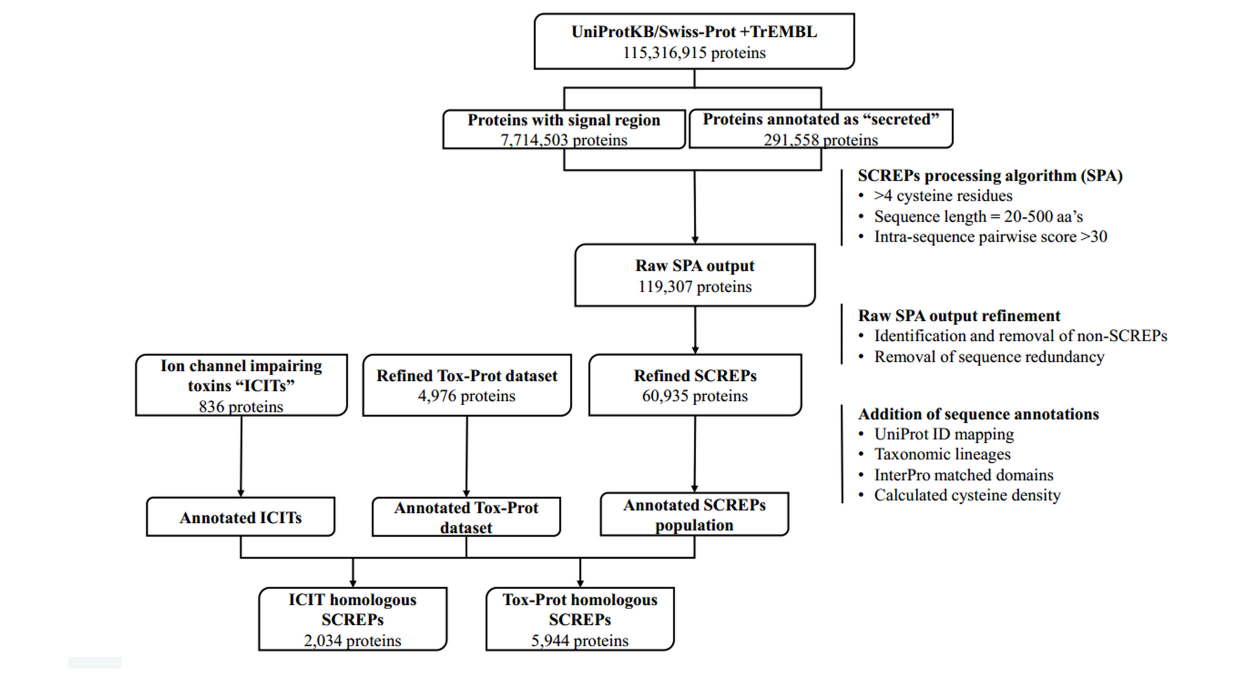
FIGURE 3 | SCREPs data mining pipeline. An overview of the entire SCREPs data mining pipeline, from the generation of SCREP sequences originating from UniProtKB, up to methods of data refinement as well as population and sequence analysis. Beneath each major step is the resulting number of protein sequences with additional details toward the right, outlining important elements within the major steps of the SCREPs processing algorithm (SPA), data refinement, and application of dataset